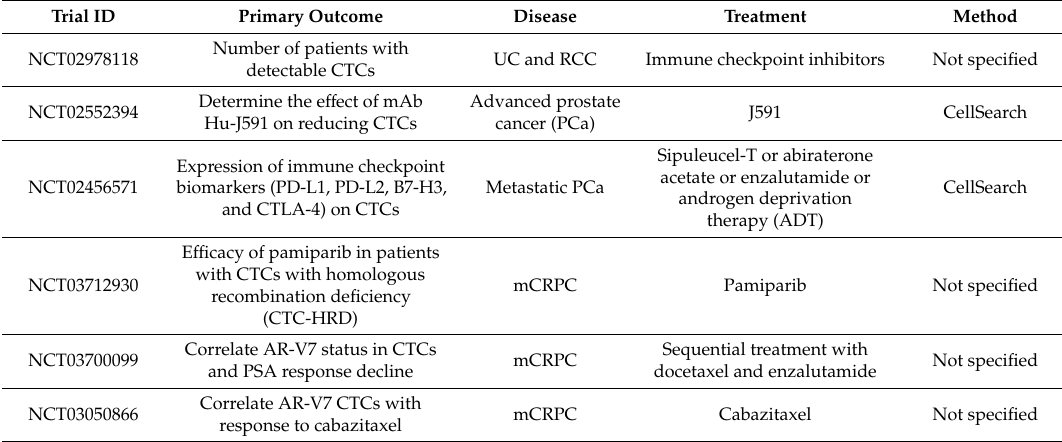
Table 2. Ongoing trials on CTCs in genitourinary